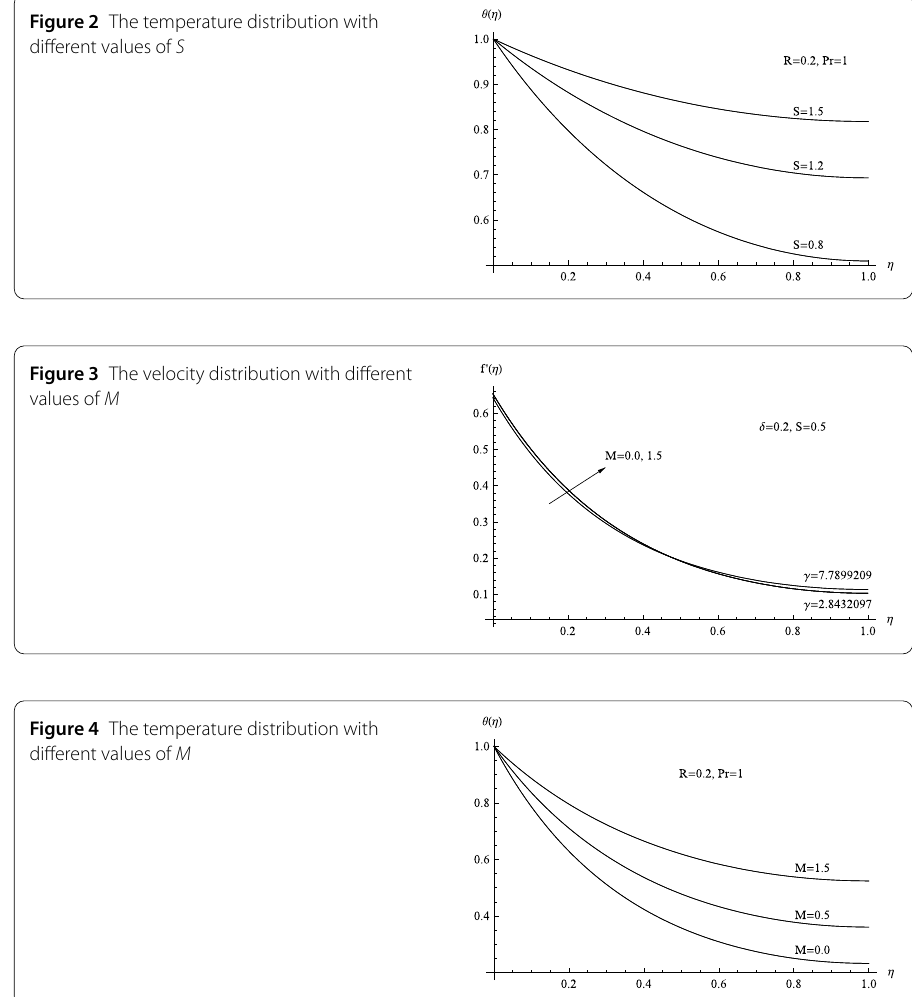
Figure 2 The temperature distribution with different values of S